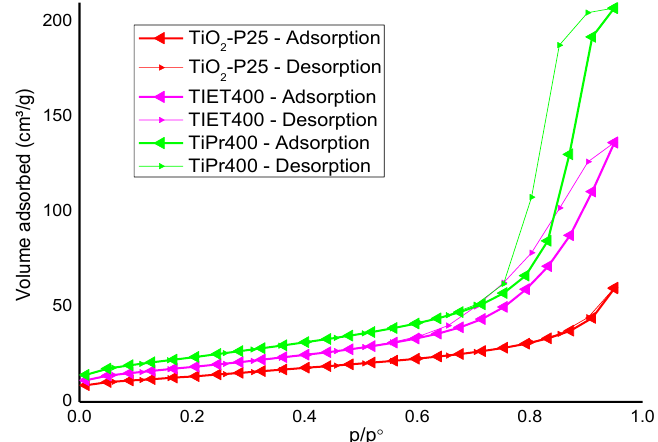
Figure 3. N 2 adsorption-desorption isotherms of the calcined samples and that of TiO 2 -P25 as